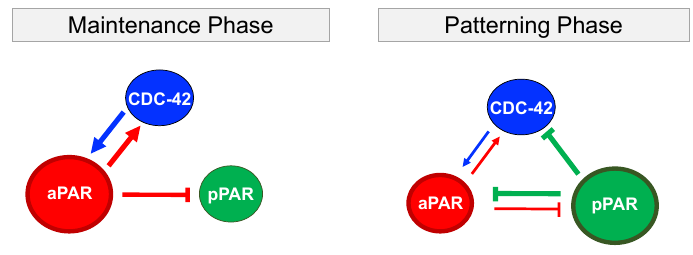
Figure 5. Critical interactions during maintenance and generation of Par protein polarization. A bigger circle indicates a key role for that protein in the indicated phase. In the maintenance phase, aPAR plays a key role in maintaining spatial polarity via interactions with CDC-42. aPAR enforces pPAR polarity through mutual inhibition. In the patterning phase, pPAR is playing the key role by inhibiting aPAR through either direct or CDC-42-mediated inhibition. CDC-42 is indispensable for both the maintenance and emergence of polarization, but does not play a critical role in the dynamics of either